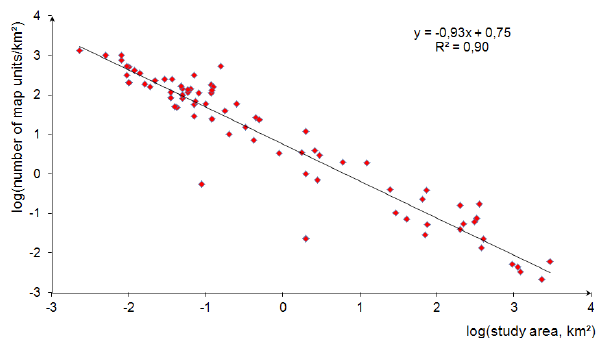
Figure 5. Relationship between the number of map units vs. the study area (log-transformed variables). 2002–early 2014 period (see Fig.